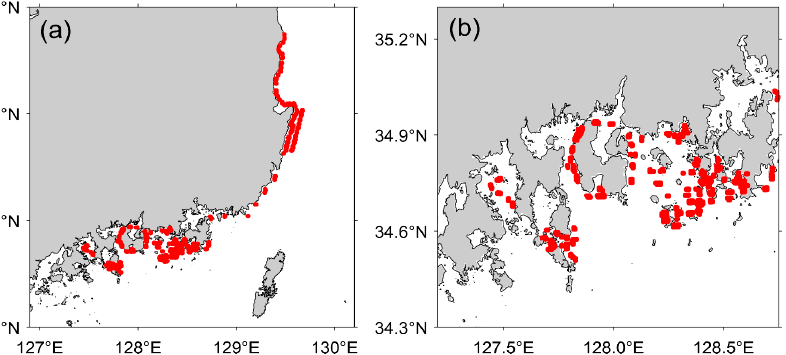
Figure 5. ( a ) Red tide report map and ( b ) enlarged southern coastal area of ( a ) on 13 August 2013 (source: National Institute of Fisheries Science), where the red-colored areas indicate the places where red tide events were observed.